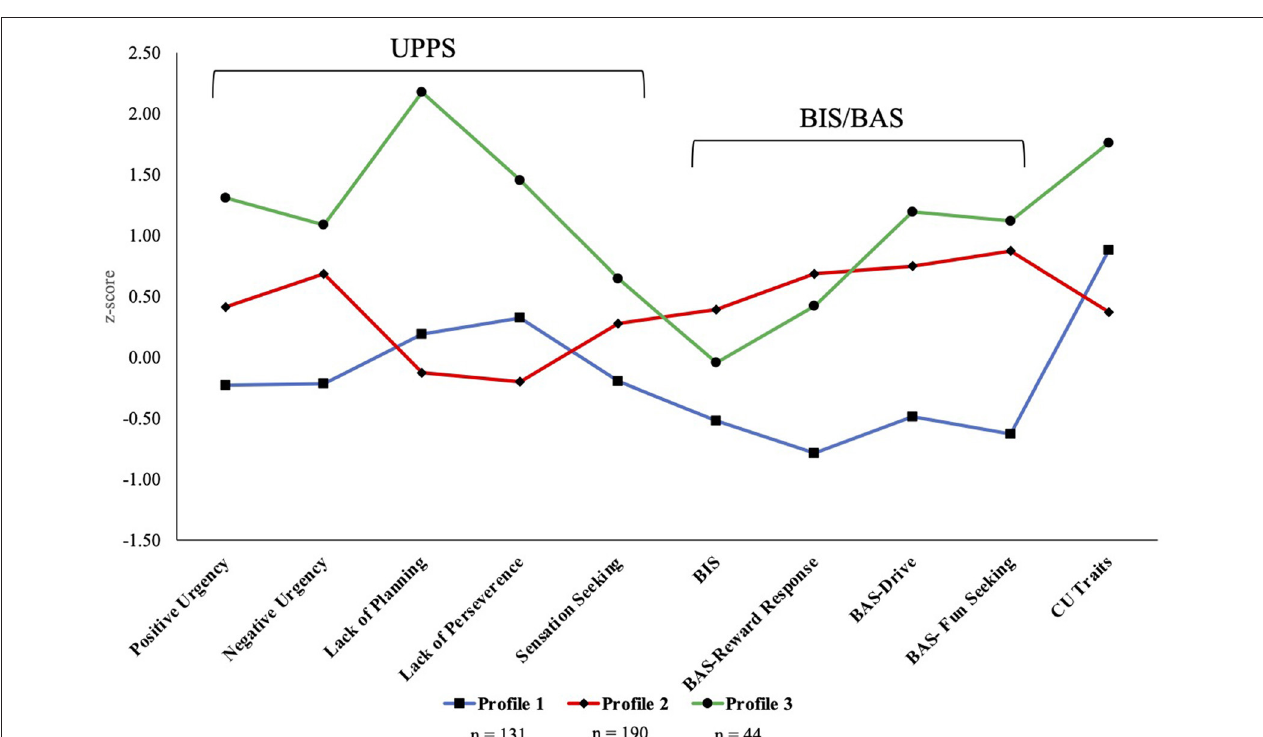
FIGURE 1 | Personality type profiles. BIS, behavioral inhibition system; BAS, behavioral activation system; CU, callous unemotional.